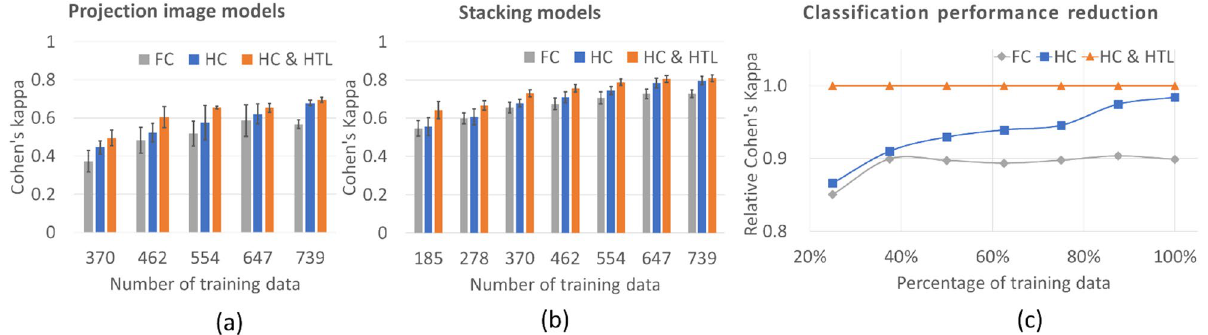
Figure 4. Performance change with different training dataset sizes. (a) Cohen’s kappa with standard deviation error bars for deep learning models trained with different training methods based on single-input (projection) images. (b) Cohen’s kappa with standard deviation error bars for deep learning models trained with different training methods based on all input images. (c) Calculated classification performance reduction for models using different training datasets and other training methods with stacking, with respect to Cohen’s kappa for the CNN model built with the proposed method of HC & HTL with stacking.